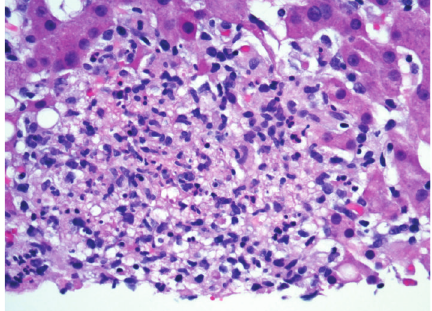
Figure 2: H&E staining of biopsy specimen showing hepatic granuloma in 40x